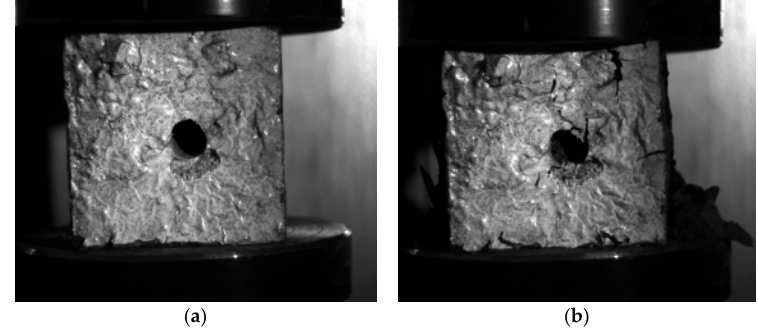
Figure 4. Sample images: ( a ) before sample destruction; ( b ) after sample destruction.